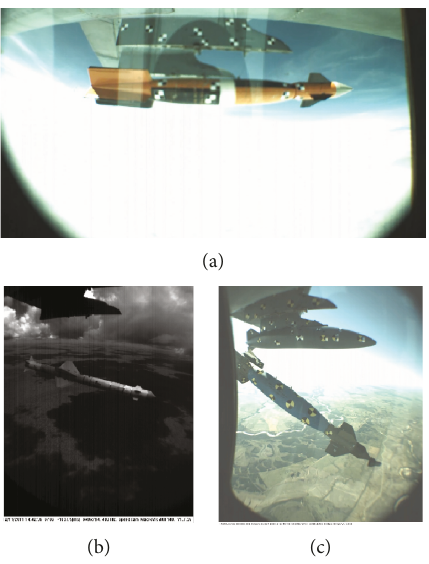
Figure 3: Example of some scenarios: (a) high luminous intensity, (b) low illumination, and (c) sky and earth.